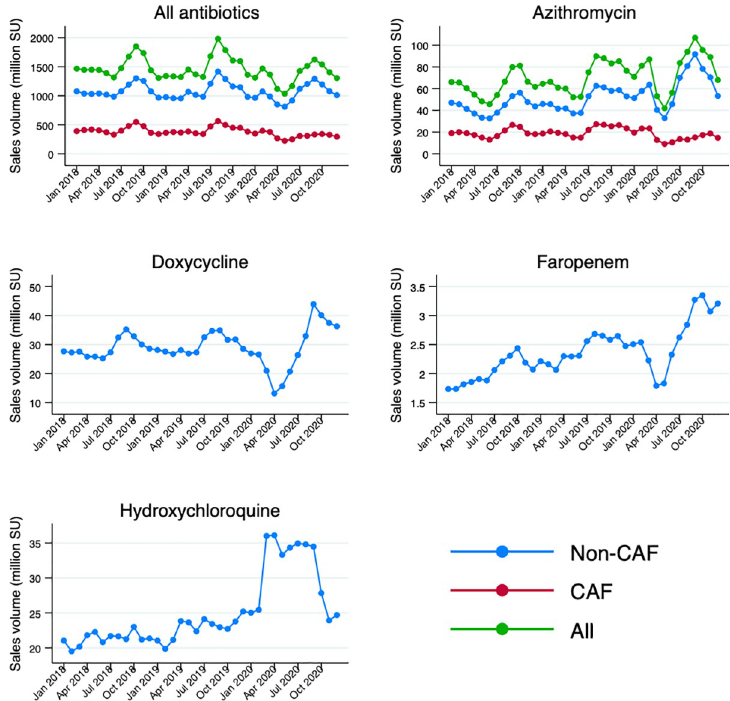
Fig 1. Trend in sales volumes of total antibiotics, azithromycin, doxycycline, faropenem, and HCQ in India from January 2018 to December 2020. CAF, non-CAF, and total sales are presented in the graphs, as relevant. Data on antibiotics are inclusive of azithromycin. HCQ and faropenem are only shown as non-CAFs because CAFs are not available for these drugs. As only a very small proportion of doxycycline is sold as CAF, this is omitted in the graph. CAF, child appropriate formulations; HCQ, hydroxychloroquine, SU, standard